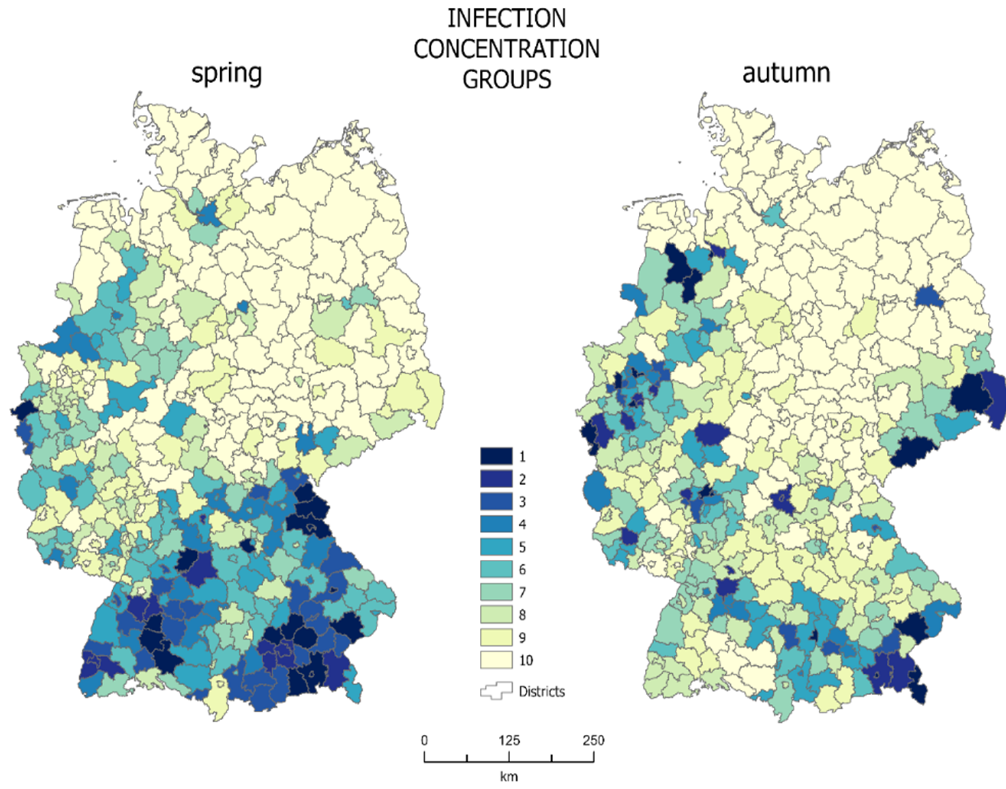
Figure 4. Choropleth map of mosaic concentration zones (source: own work).